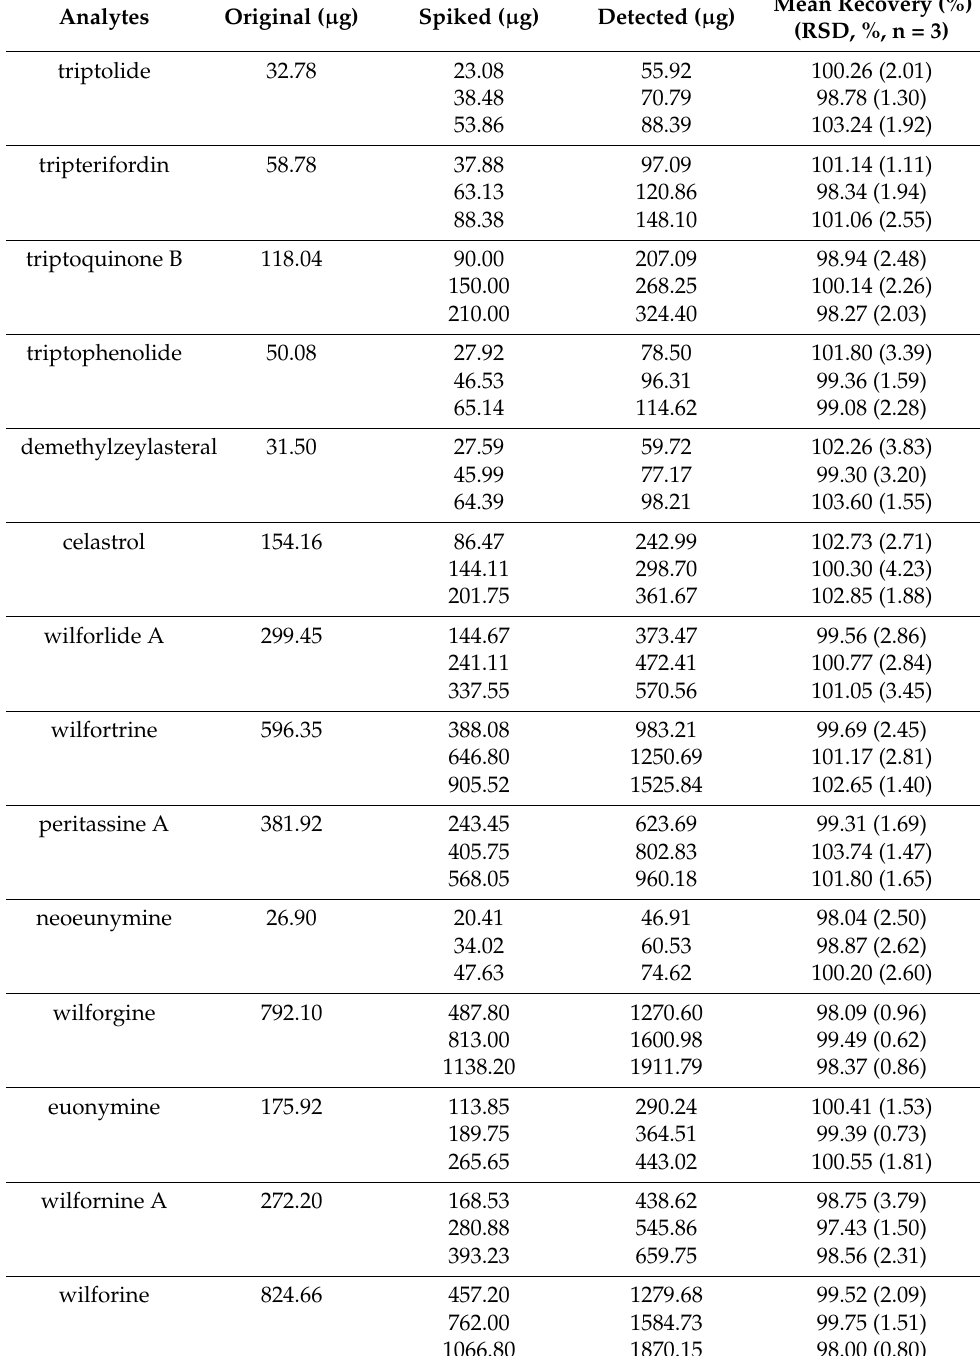
Table 4. Recoveries of the 14